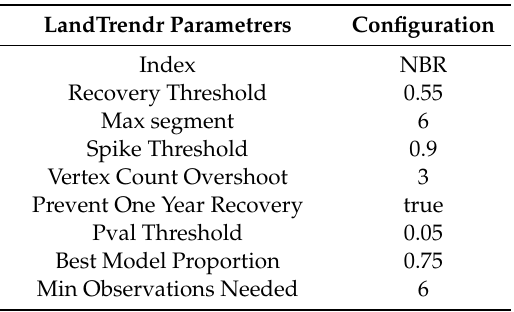
Table 1. Values of the calibration of LandTrendr parameters used to map clearcut forest